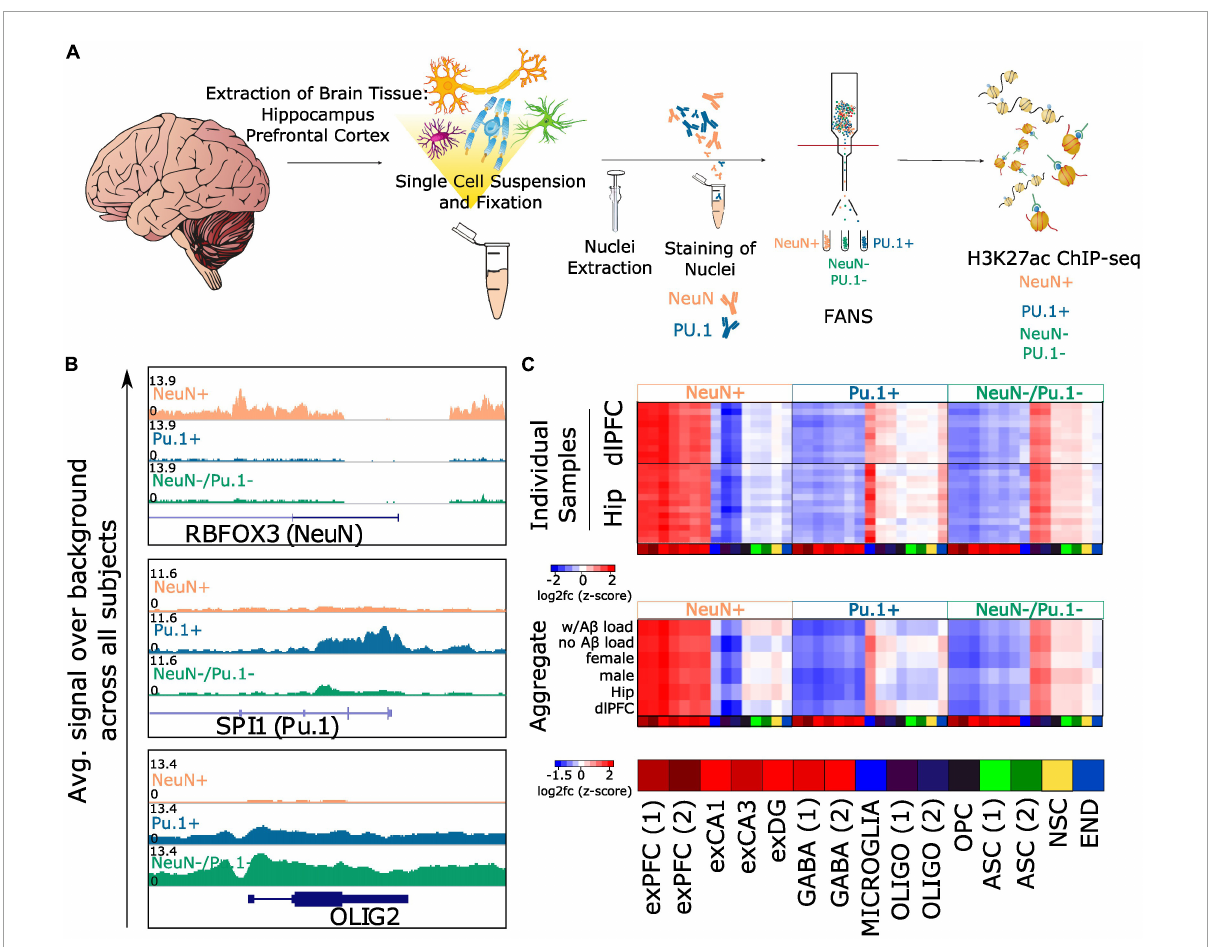
FIGURE1 FANS sorting captures neurons, microglia and oligodendrocyte enriched populations from postmortem brain tissue. (A) Workflow for sorting nuclei and performing H3K27ac ChIP-seq from postmortem human brain tissue: nuclei were isolated from fresh frozen hippocampus or prefrontal cortex and FANS was performed to collect NeuN+, Pu.1+, and NeuN-/Pu.1- populations. H3K27ac ChIP-seq was performed on each population (B) . Genome browser visualization of H3K27ac signal over background (Input) averaged across all profiled samples for the three populations. Loci containing the genes RBFOX3 (NeuN), SPI1 (Pu.1) and OLIG2 (an oligodendrocyte marker) are visualized (C) . Top heatmap displaying average H3K27ac enrichment at the promoters of marker genes ( < 5kb from TSS) from 15 cell type clusters profiled in Habib et al. (2017). Rows represent individual tissue samples. Columns represent the 15 different cell type clusters and are repeated three times to display NeuN+ specificity, Pu.1+ specificity and NeuN-/Pu.1- specificity. Bottom collapsed version of the top heatmap created by averaging the log2fc values for groups of samples defined by A β load, sex and brain region. Habib et al. (2017) cell type cluster abbreviations are defined here: exPFC, glutamatergic neurons from the PFC; GABA, GABAergic interneurons; exCA1/3, pyramidal neurons from the hippocampus CA region; exDG, granule neurons from the hippocampus dentate gyrus region; ASC, astrocytes; MICROGLIA, microglia; OLIGO, oligodendrocytes; OPC, oligodendrocyte precursor cells; NSC, neuronal stem cells; END, endothelial cells.